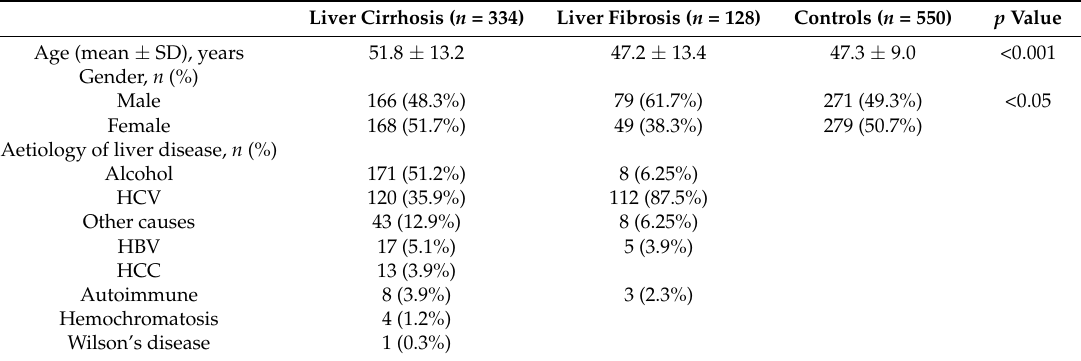
Table 1. Characteristics of patients with liver cirrhosis, hepatic fibrosis and